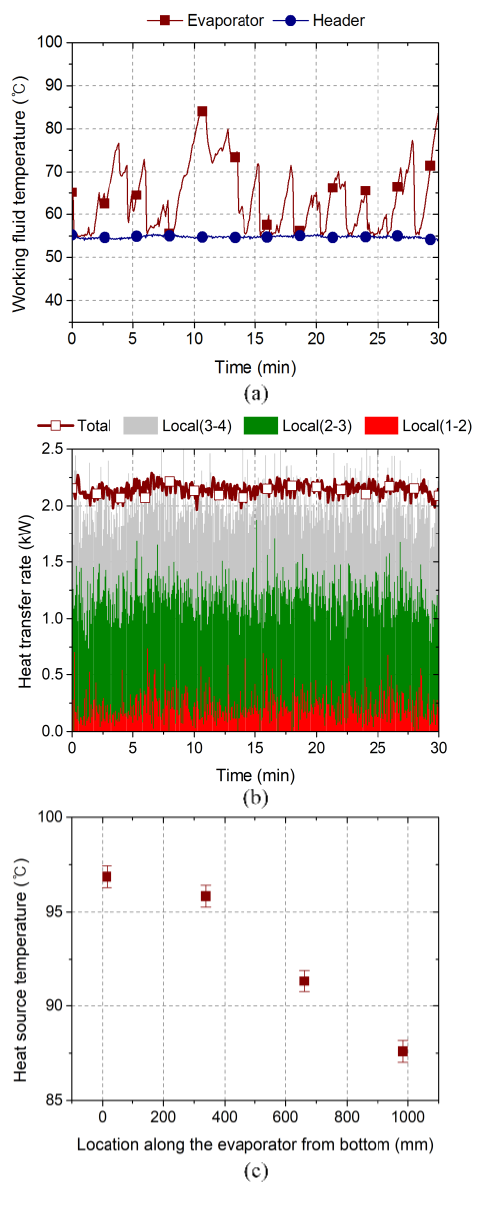
Figure 18. Operating characteristics of an FHP with a heat source temperature of 96.4 °C: ( a ) working fluid temperature, ( b ) cumulative heat transfer rate, and ( c ) local heat source temperature.